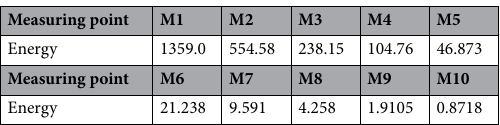
Table 3. Traveling wave energy at different measuring points of an overhead line (scenario 1).